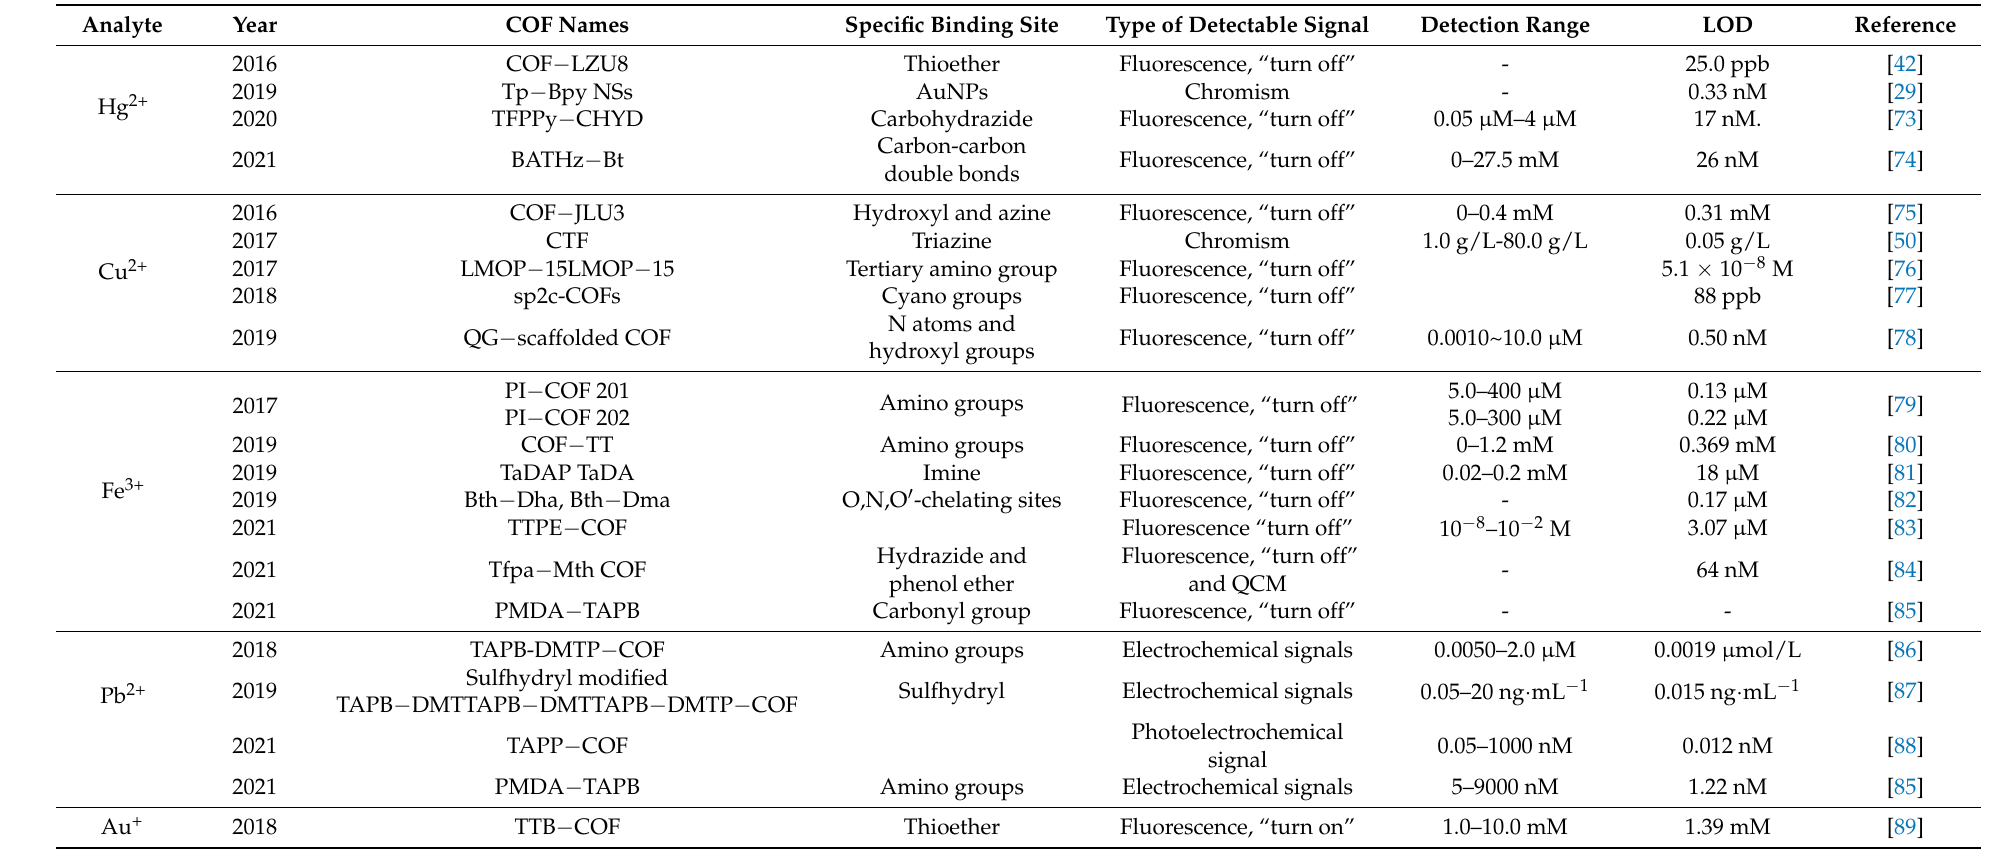
Table 3. COF-based ion